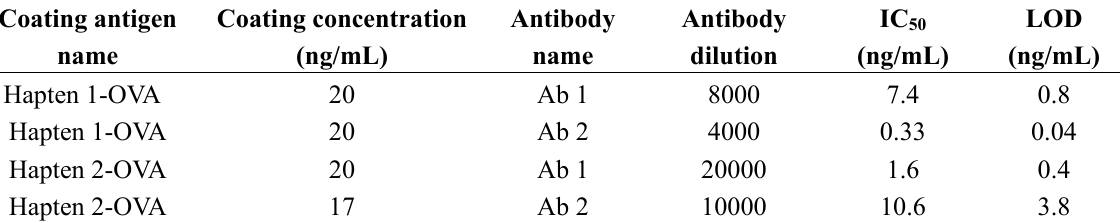
Table 1. Optimized icELISA conditions.